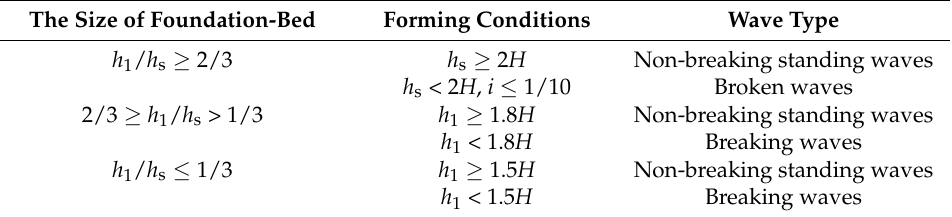
Figure 1. Three wave types in front of vertical seawalls [1]. ( a ) non-breaking standing waves; ( b ) breaking waves; ( c ) broken waves. Table 1. The conditions to form three wave types in front of a vertical seawall.